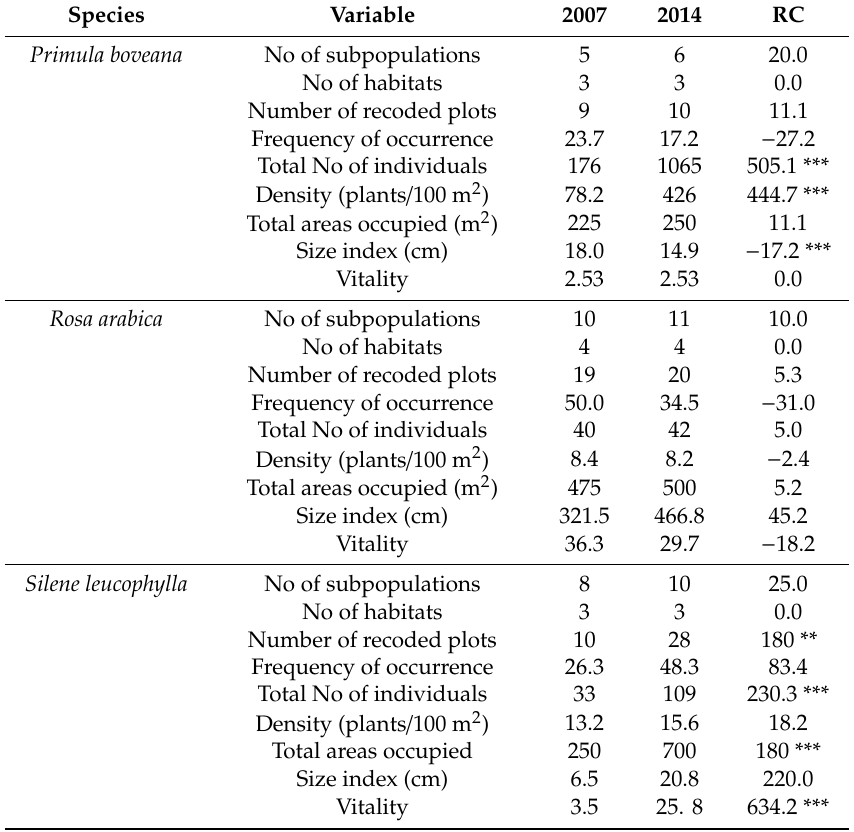
Table 3. Relative change over seven years (2007—2014) in number of individuals and population attributes in three endemic species growing in the Saint Katherine Protectorate